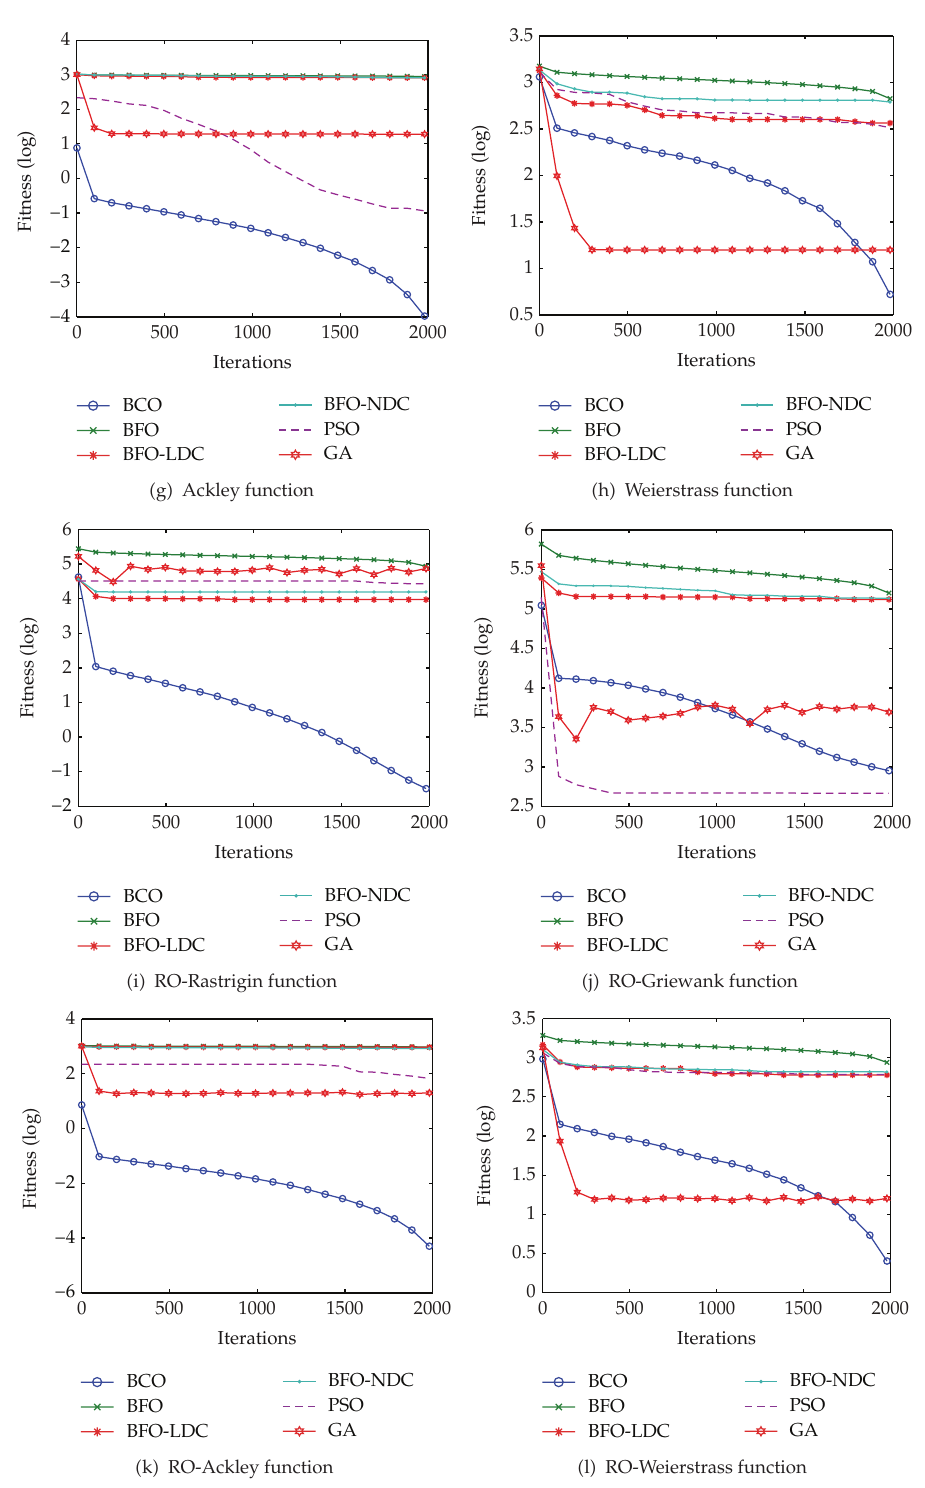
Figure 6: The median convergence characteristics of 15-D test